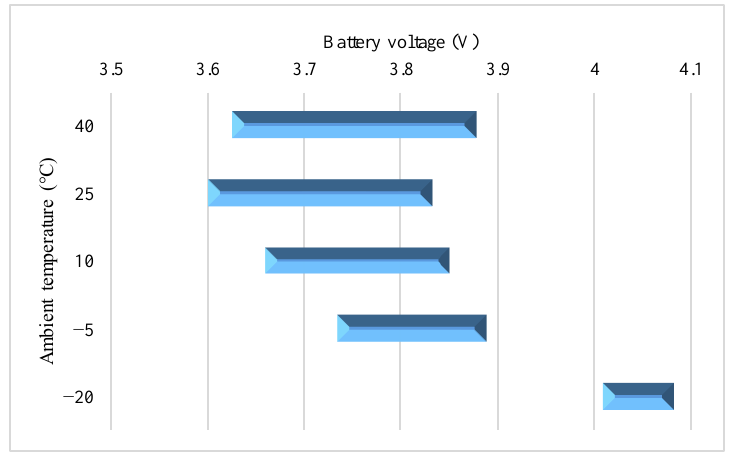
Figure 12. The voltage fluctuation intervals during the VPP with 0.50C charging. The charging capabilities are 19.01 Ah, 20.34 Ah, 17.34 Ah, and 15.34 Ah, representing 51.63%, 55.39%, 50.61%, and 50.48% of the total charging capacity, all of which are higher than 50%. It is discovered that the temperature varies gradually and avoids the maximum